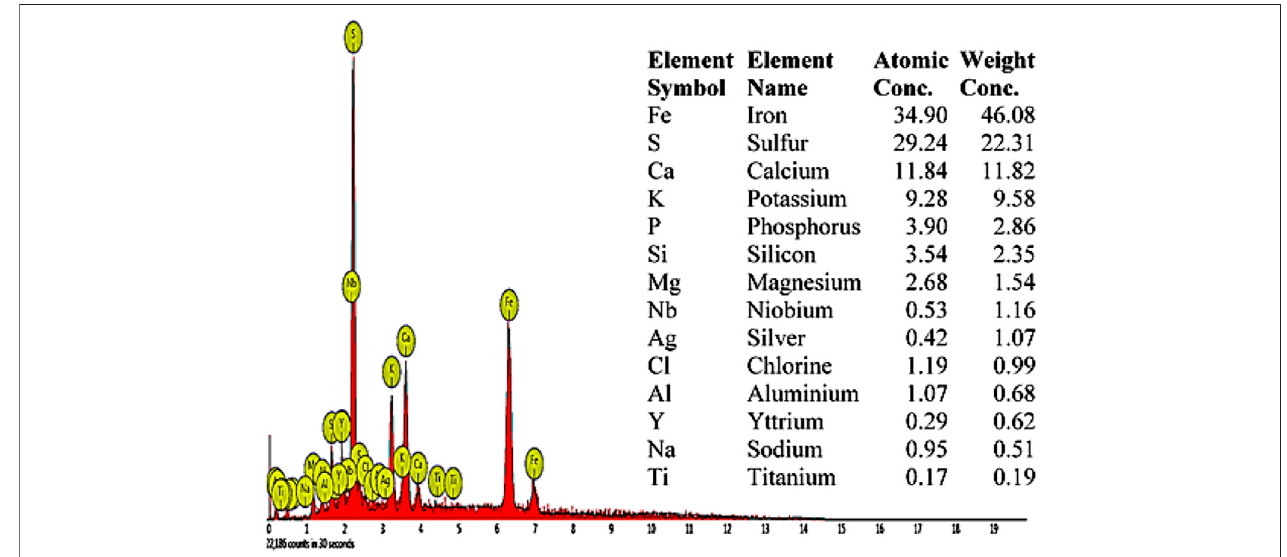
FIGURE 2 | EDX image of FSPD catalyst.